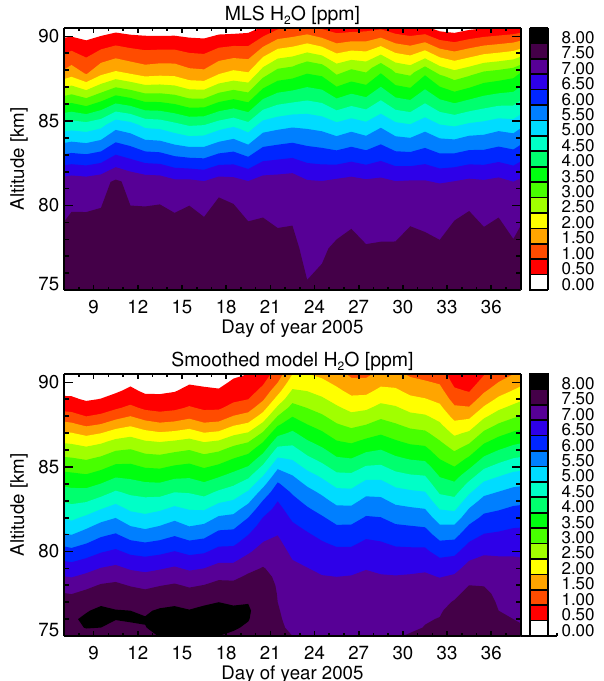
Fig. 8. Water mixing ratio [ppm] at 75 ◦ S around the SPE Jan- uary 2005. Upper panel: daily mean zonally averaged (70–80 ◦ S) MLS water vapor. Lower panel: model water as in Fig. 7 but smoothed with a 12km boxcar function to account for the vertical resolution of the MLS measurements.